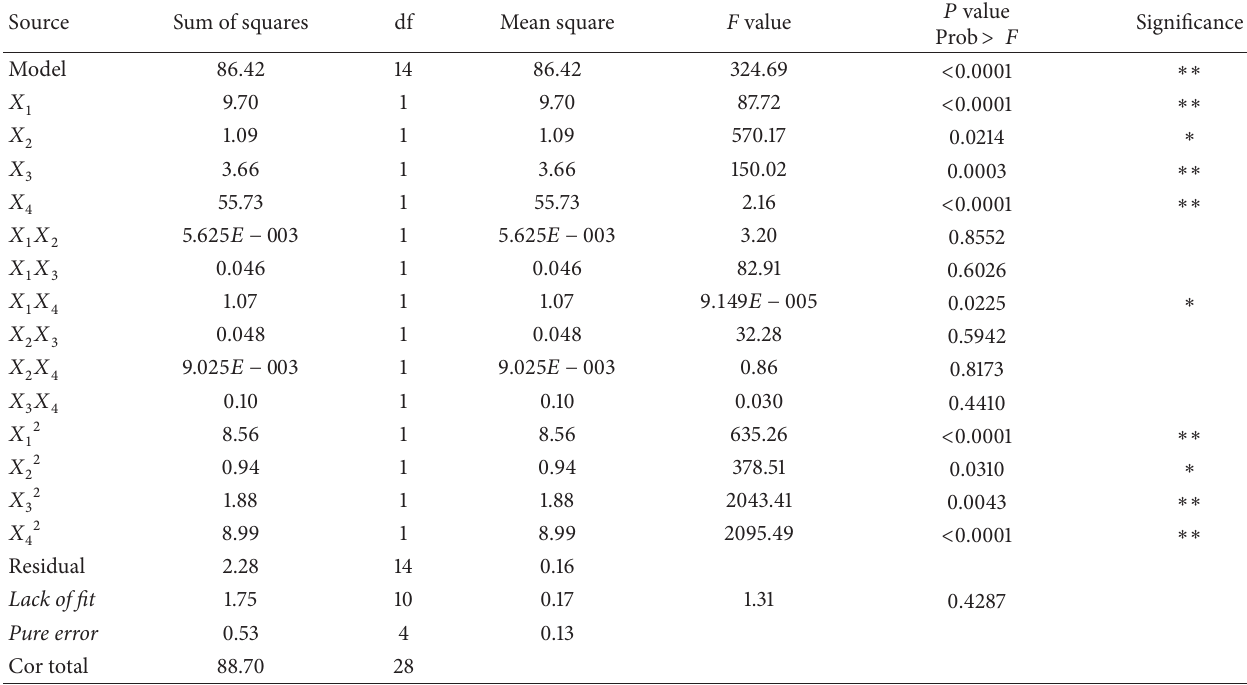
𝑃 value Significance Prob > 𝐹